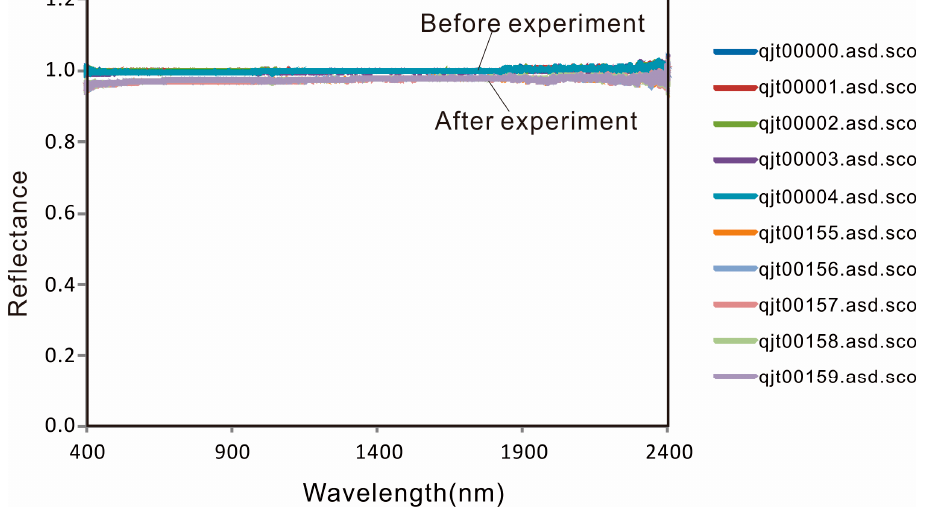
Figure 3. Spectral of white reference before and after the experiment.